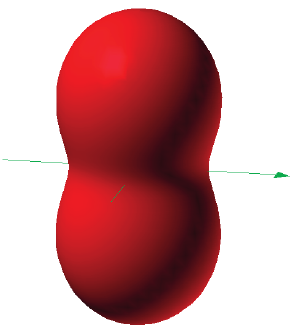
Figure 11. Potential surface of a